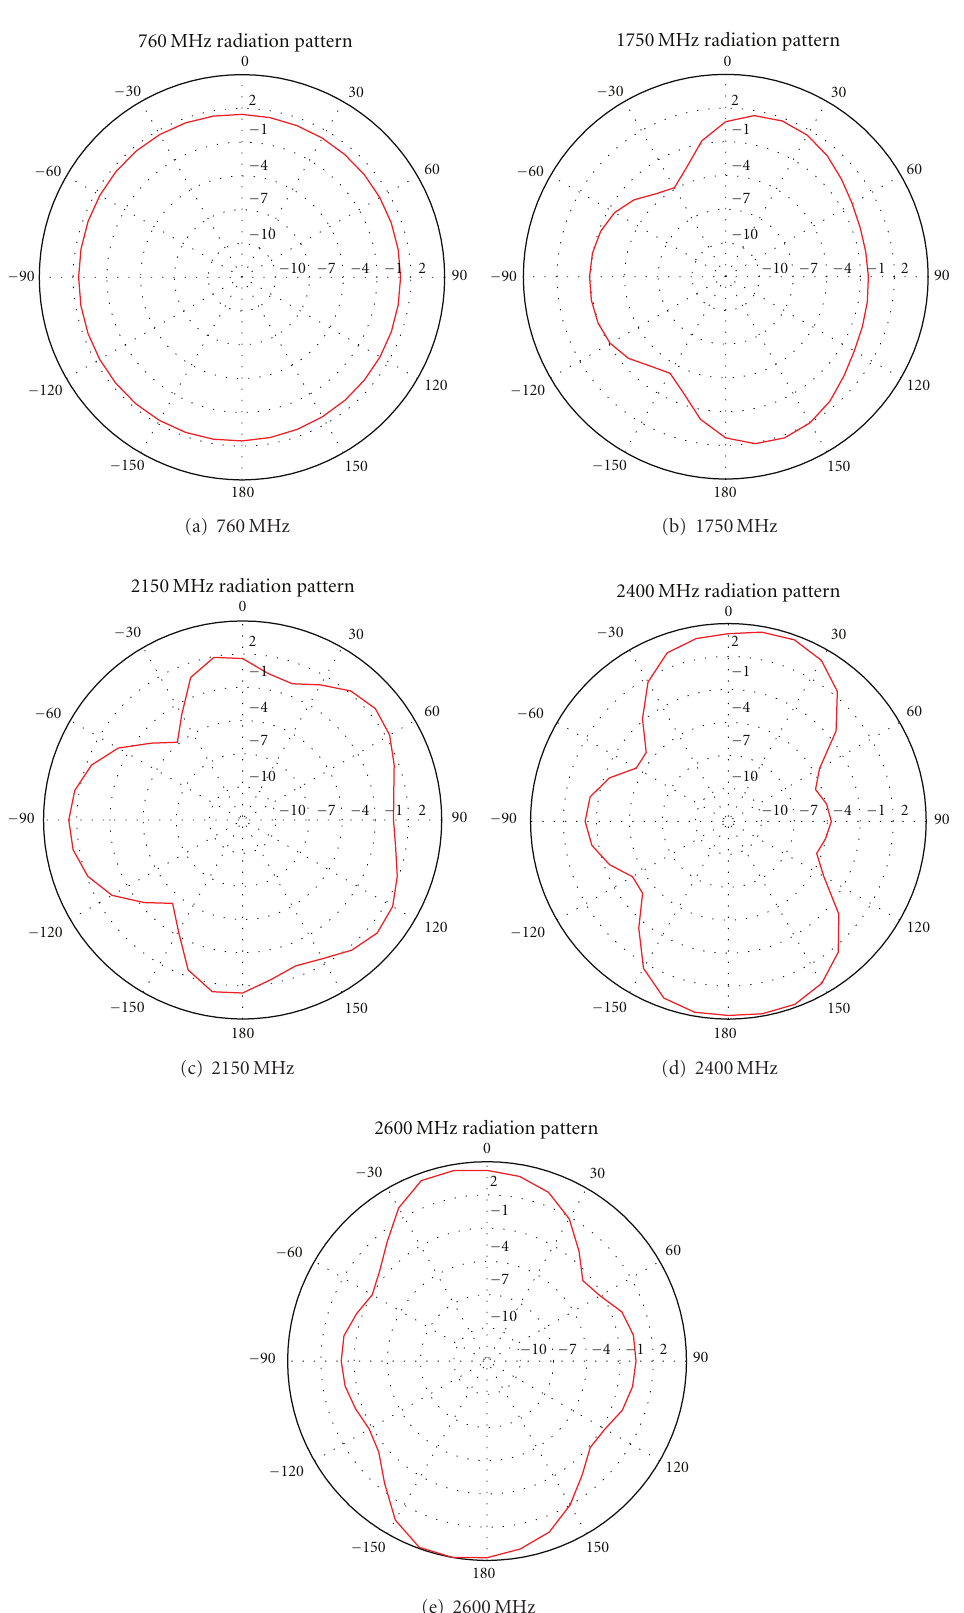
Figure 9: Radiation patterns of antenna 2 in y - z